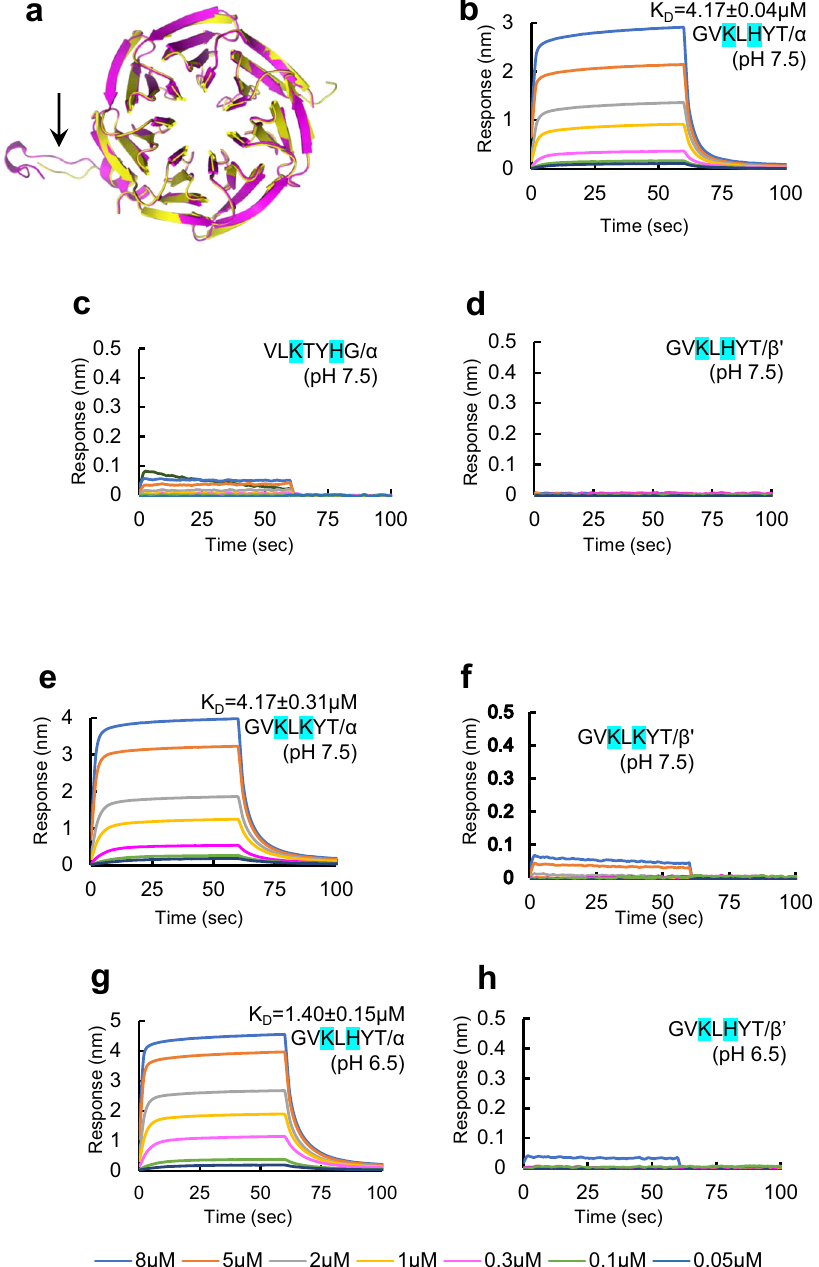
Fig. 2 Direct binding interaction of sarbecovirus spike hepta-peptide with α COPI-WD40. a Structural conservation of α COPI-WD40 domain determined in the present investigation (yellow) and a previous structure (magenta). Arrow highlights main chain differences between these two α COPI-WD40 structures in Gly 168 -Ala 188 . b – h BLI assay of N-biotinylated spike hepta-peptide with COPI-WD40 domain. One representative experiment of three is shown in panels ( b – h ). Color code for concentrations is given at the bottom of the fi gure. The equilibrium K D is provided with each sensorgram for comparison. b The spike wild-type peptide sequence demonstrates dose-dependent binding to α COPI-WD40 domain. c Scrambling of the hepta-peptide sequence abolishes binding suggesting sequence-speci fi c interaction. d β ’ COPI-WD40 demonstrates no interaction with the immobilized hepta-peptide. The mutant peptide, Gly-Val-Lys-Leu-Lys-Tyr-Thr, shows dose-dependent binding to ( e ) α COPI-WD40 but not ( f ) β ’ COPI-WD40. g Acidi fi cation enhances binding between the wild-type spike hepta-peptide and α COPI-WD40 domain. h β ’ COPI-WD40 shows weakly enhanced binding to the spike hepta-peptide upon acidi fi cation. “ n.d. ” implies not determined for weak